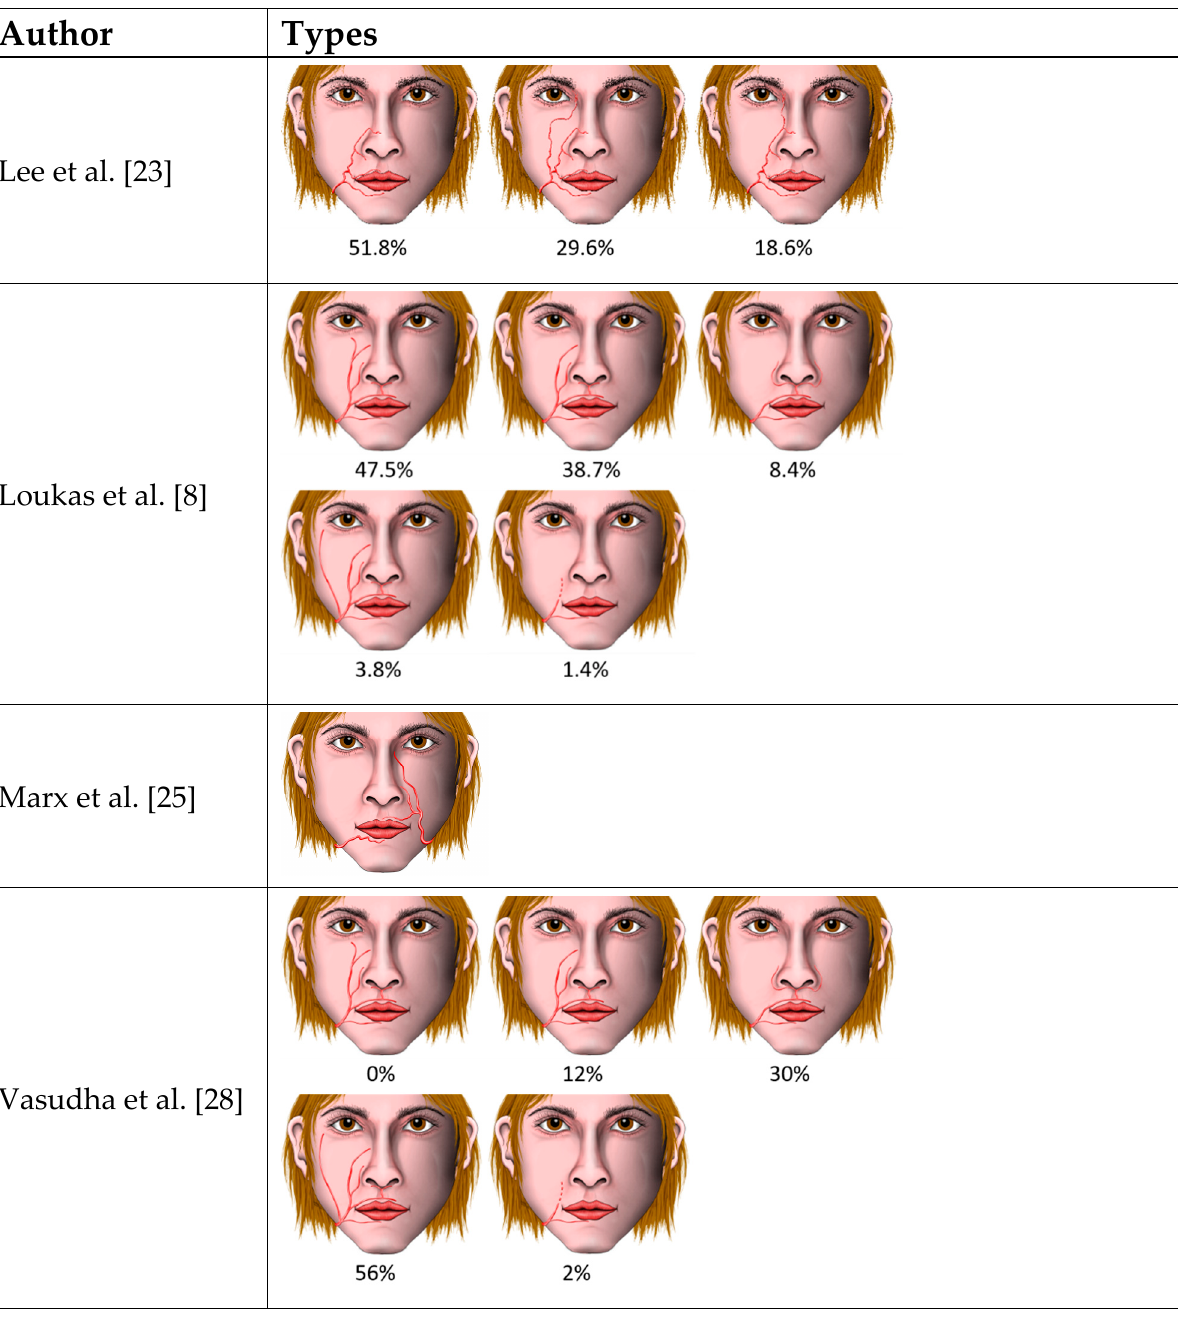
Figure 3. Types of facial artery branching patterns. Frontal views according to the original depiction.